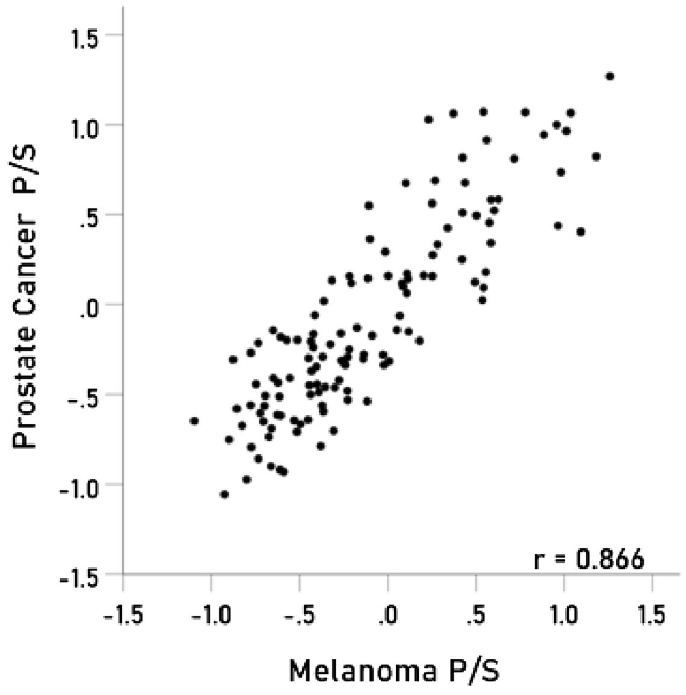
Figure 4. Immunogenetic P/S estimates for prostate cancer are plotted against those for melanoma. P < 0.001; N = 127.